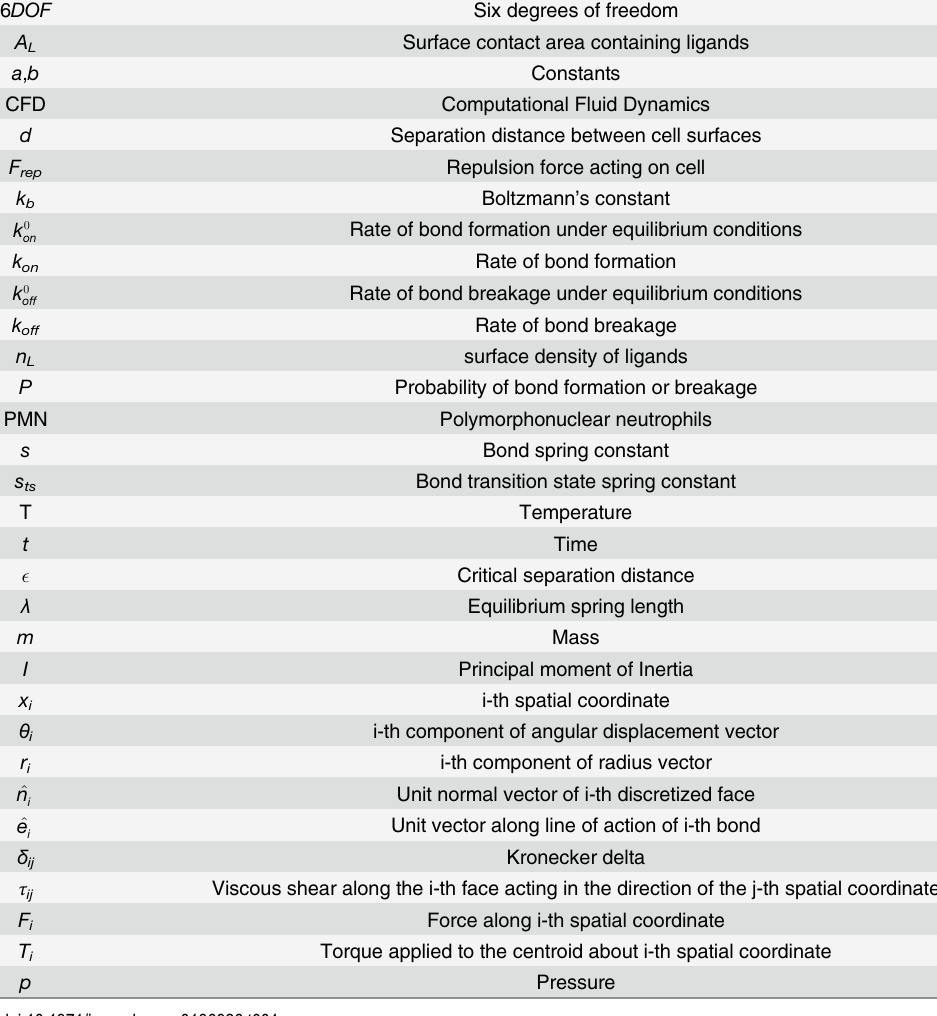
Table 1. List of